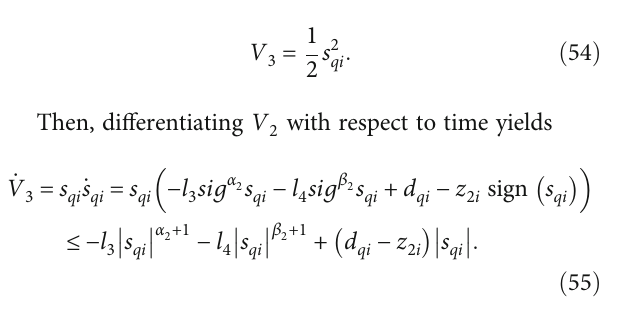
Figure 2: Communication